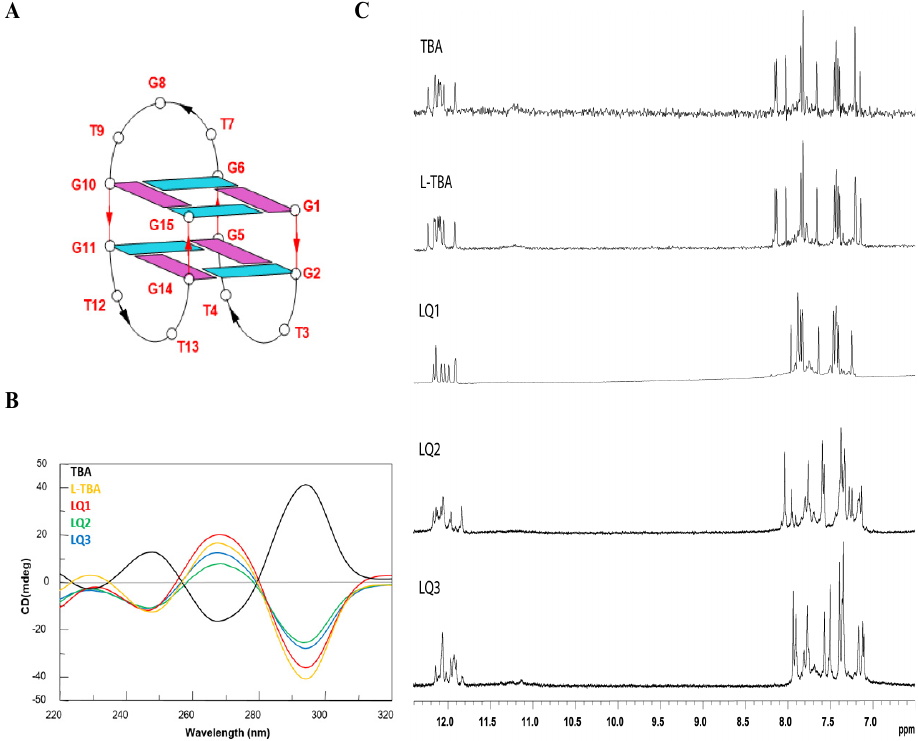
Figure 1. Structural investigations of the thrombin binding aptamer (TBA) derivatives. ( A ) Schematic representation of the G-quadruplex structure adopted by TBA. Guanosines in syn and anti glycosidic conformations are in purple and light blue, respectively. ( B ) CD spectra at 20 ◦ C of the modified TBAs and their natural counterpart at 50 µ M ODN strand concentration in a bu ff er solution 10